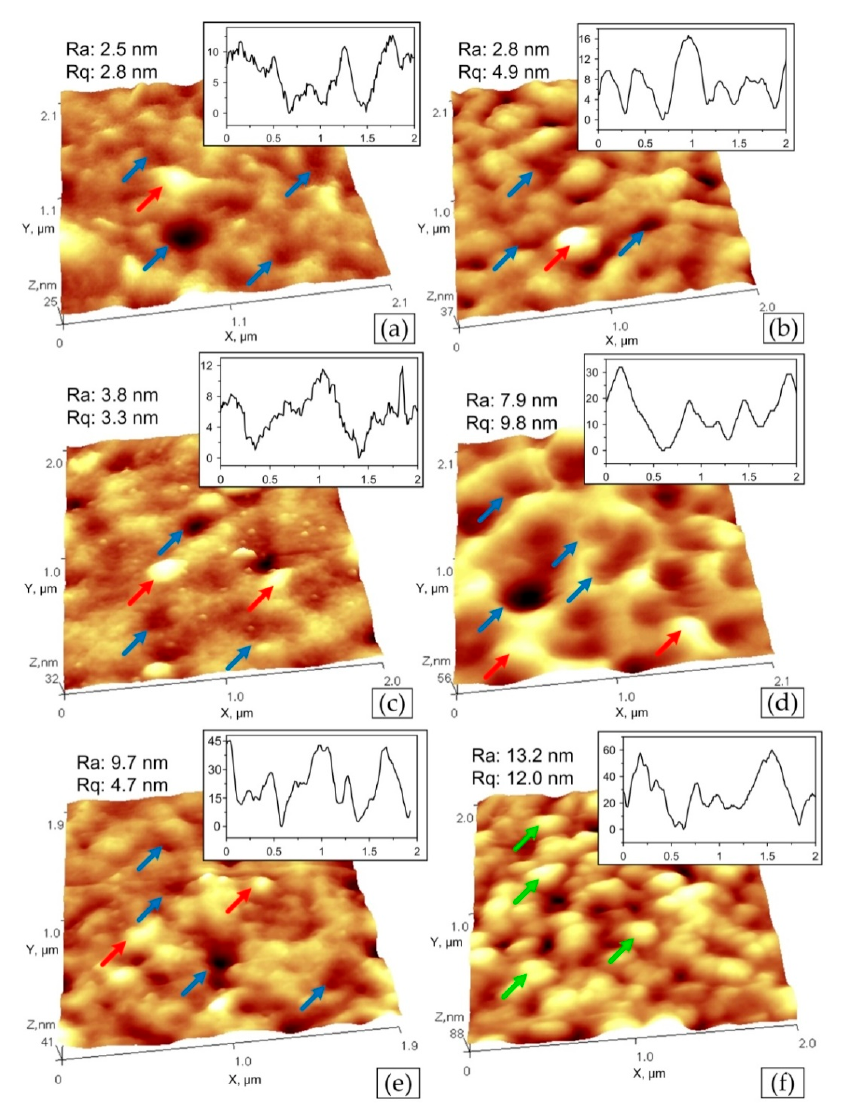
Figure 4. AFM images of Zr-O-N coating morphology with the scan size of 5 × 5 µm 2 , the relative oxygen concentration O 2(x) : ( a ) 0%, ( b ) 10%, ( c ) 20%, ( d ) 30%, ( e ) 50%, ( f ) 100% with marked surface details—“cells” (blue arrows), submicroparticles (red arrows), grains or microparticles (green arrows).